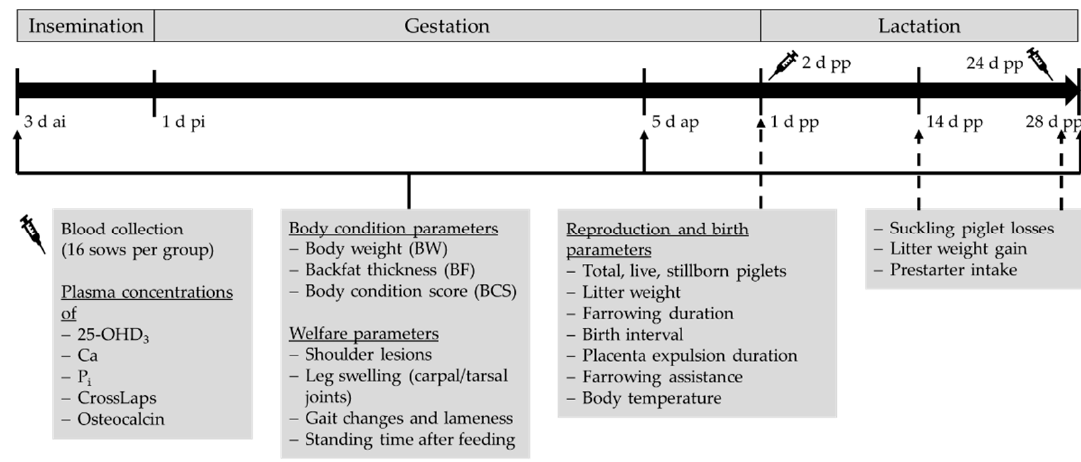
Table 3. Analyzed mean feed concentrations of vitamin D 3 and 25-OHD 3 ( μ g/kg).